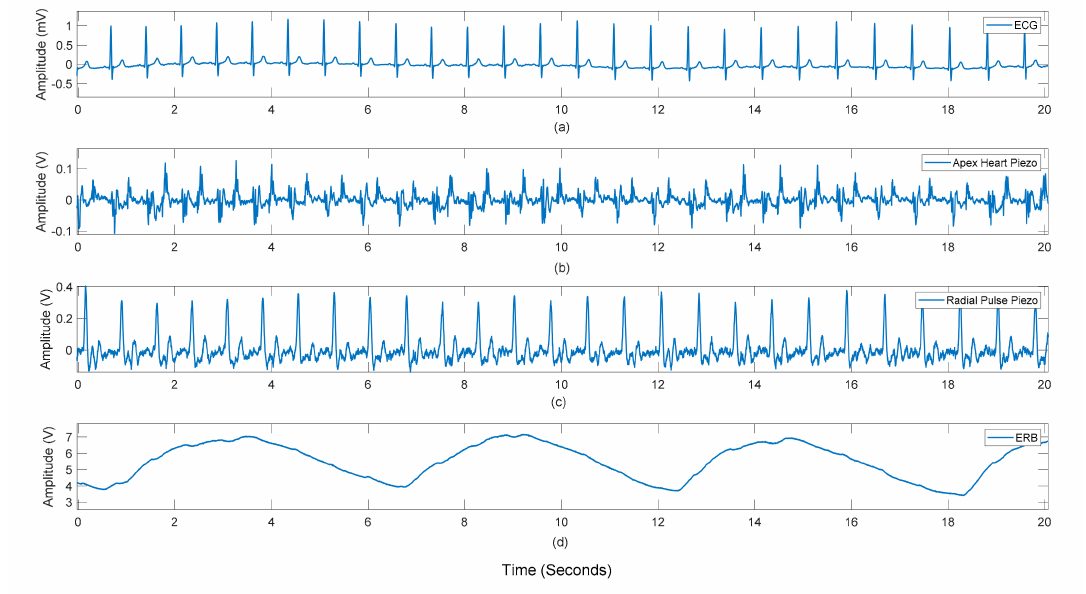
Figure 8. Subject #3 dataset: Raw recordings from ( a ) ECG signal, ( b ) sensor placed on the heart apex ( c ) sensor on the radial pulse of the wrist ( d ) the respiration band around the